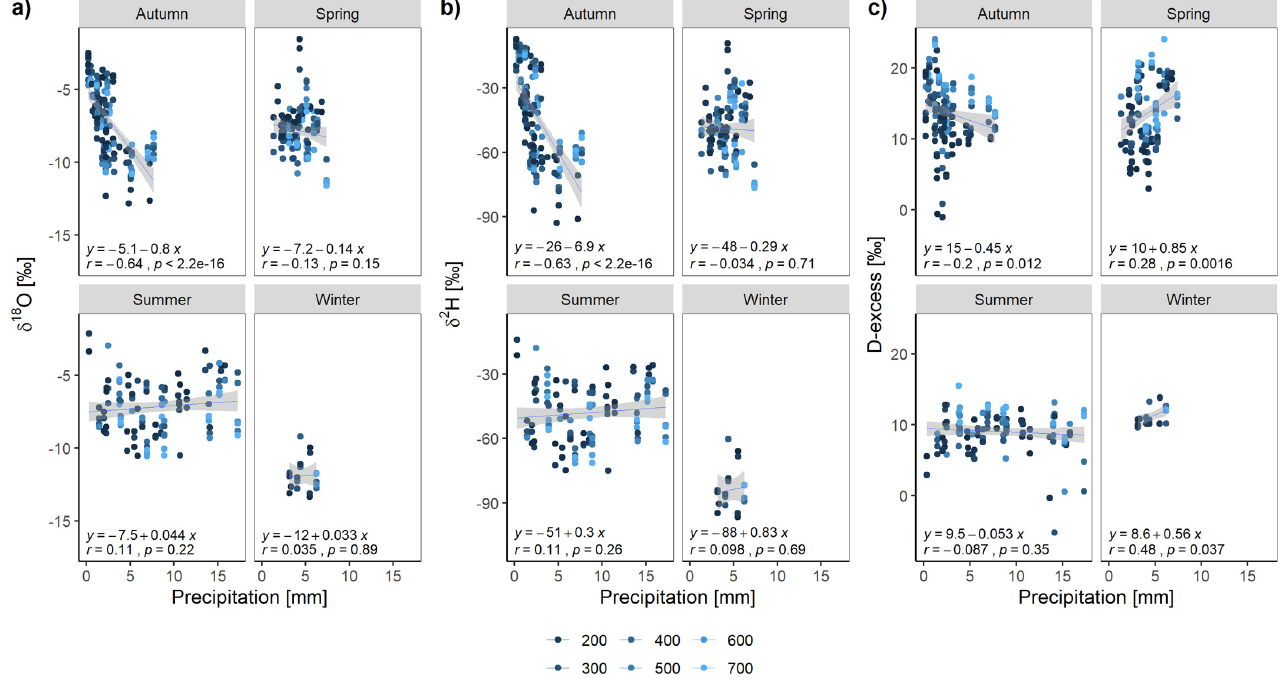
Figure 5. The isotopic values of δ 18 O ( a ), δ 2 H ( b ), and D-excess ( c ) of precipitation with precipitation amount along a representative elevation transect separated by seasons. The grey shadings represent the 95% confidence interval of the linear regression lines.